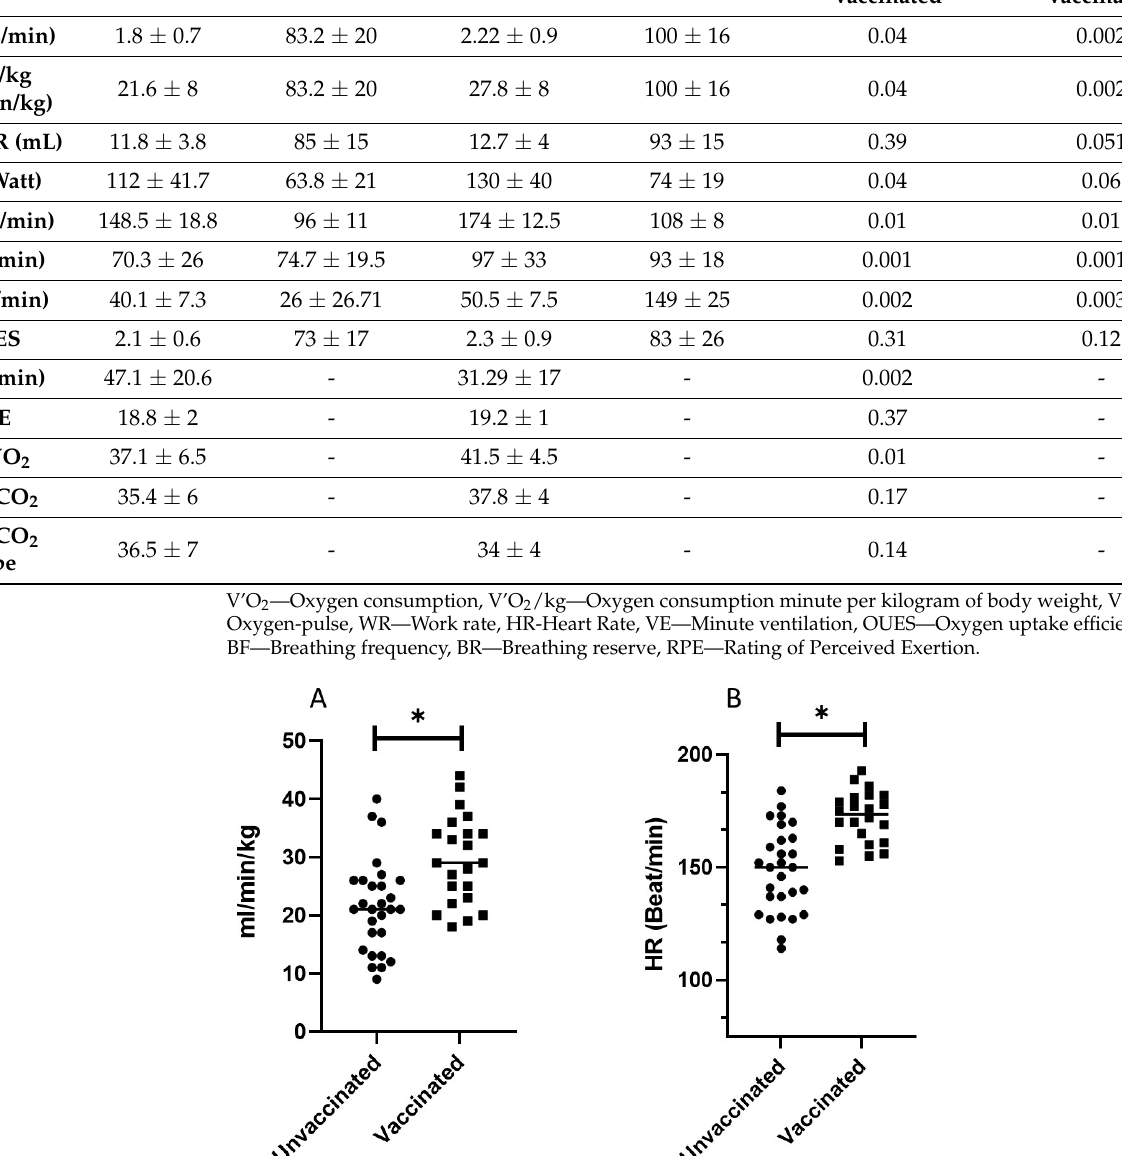
Difference in % Difference in Predicted Values Measured Values Unvaccinated vs. Unvaccinated vs. Vaccinated